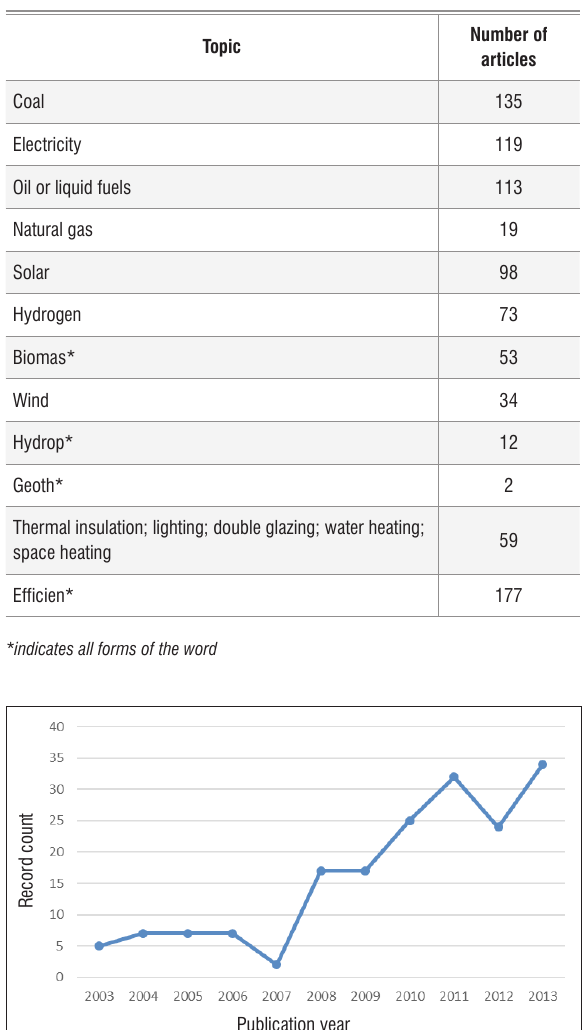
Number of Energy and Fuel articles from South Africa in the period 2003–2013 a ccording to specific topics